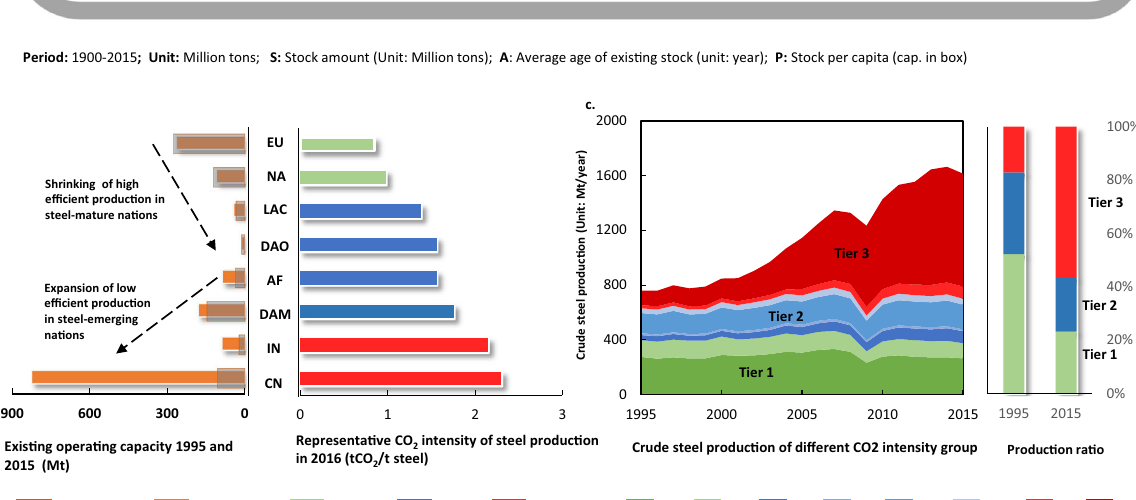
while also considering the regional structural changes in steel fl ows (particularly for emerging economies) to achieve deep